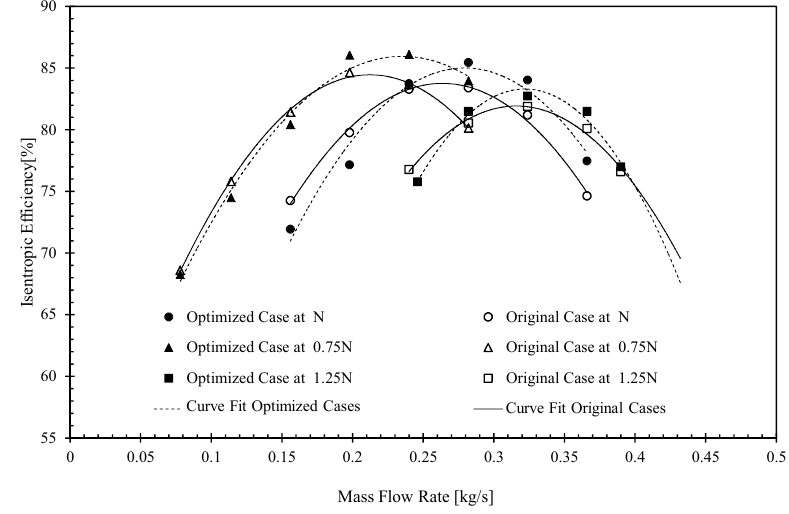
Figure 19. Isentropic efficiency vs. mass flow rate for original and optimized